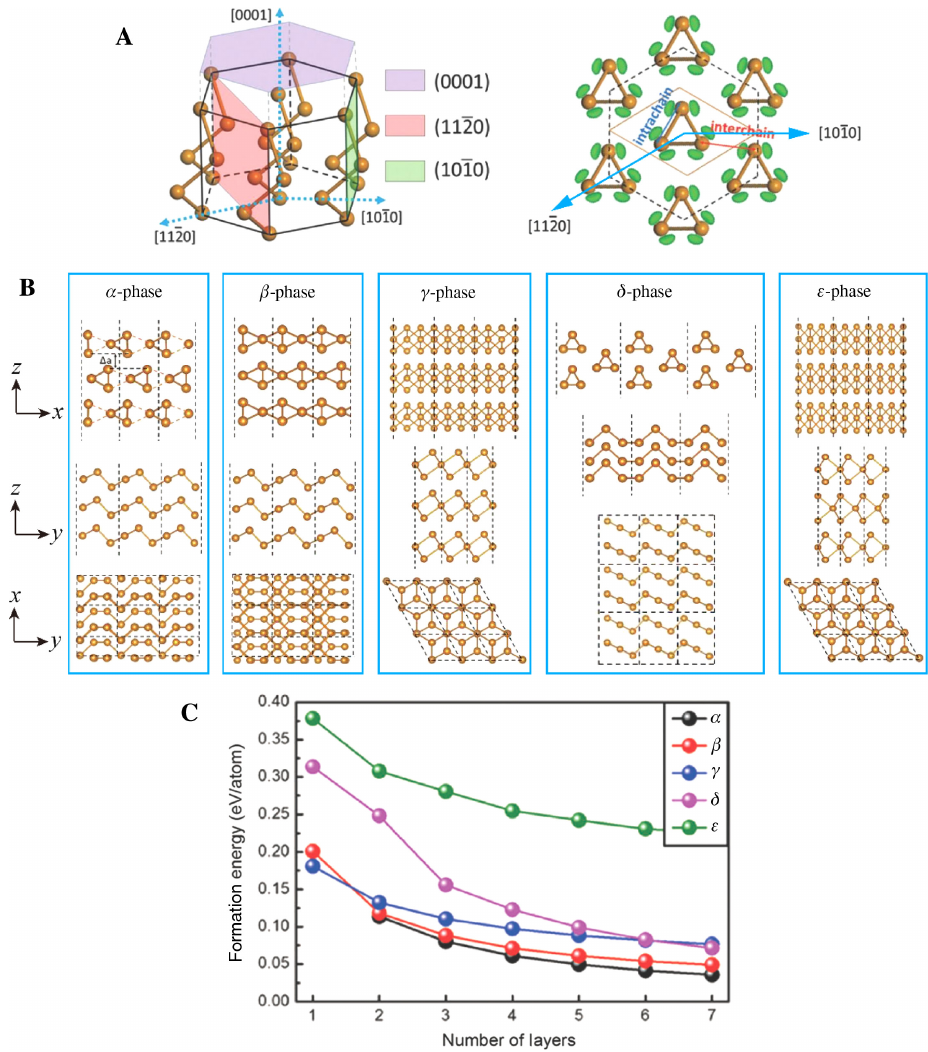
Figure 10: The geometric structure and formation energy of tellurene polymorphs. (A) Crystal structure of bulk Te or Se with helical chains stacking into hexagonal structure (Left: side view with labeled crystal orientations and planes; Right: overview with electron isosurfaces of 0.9e Bhor −3 ); (B) Side view and top view of α -, β -, γ -, δ -, and ε -tellurene ( z is the direction of vacuum layer, y is the direction along atomic chain); (C) Layer-dependent formation energy of α -, β -, γ -, δ -, and ε -tellurene. Reproduced with permission [154]. Copyright 2018, The Royal Society of